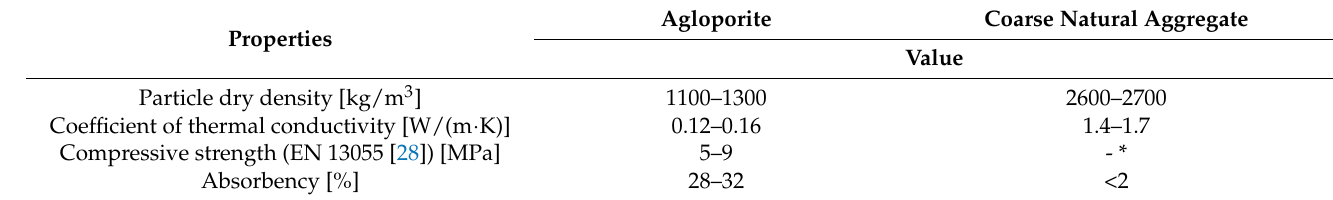
Figure 1. Sieve analysis of natural aggregate fraction 0/4 (amphibolite sand) and coarse aggregate fraction 4/8 mm.